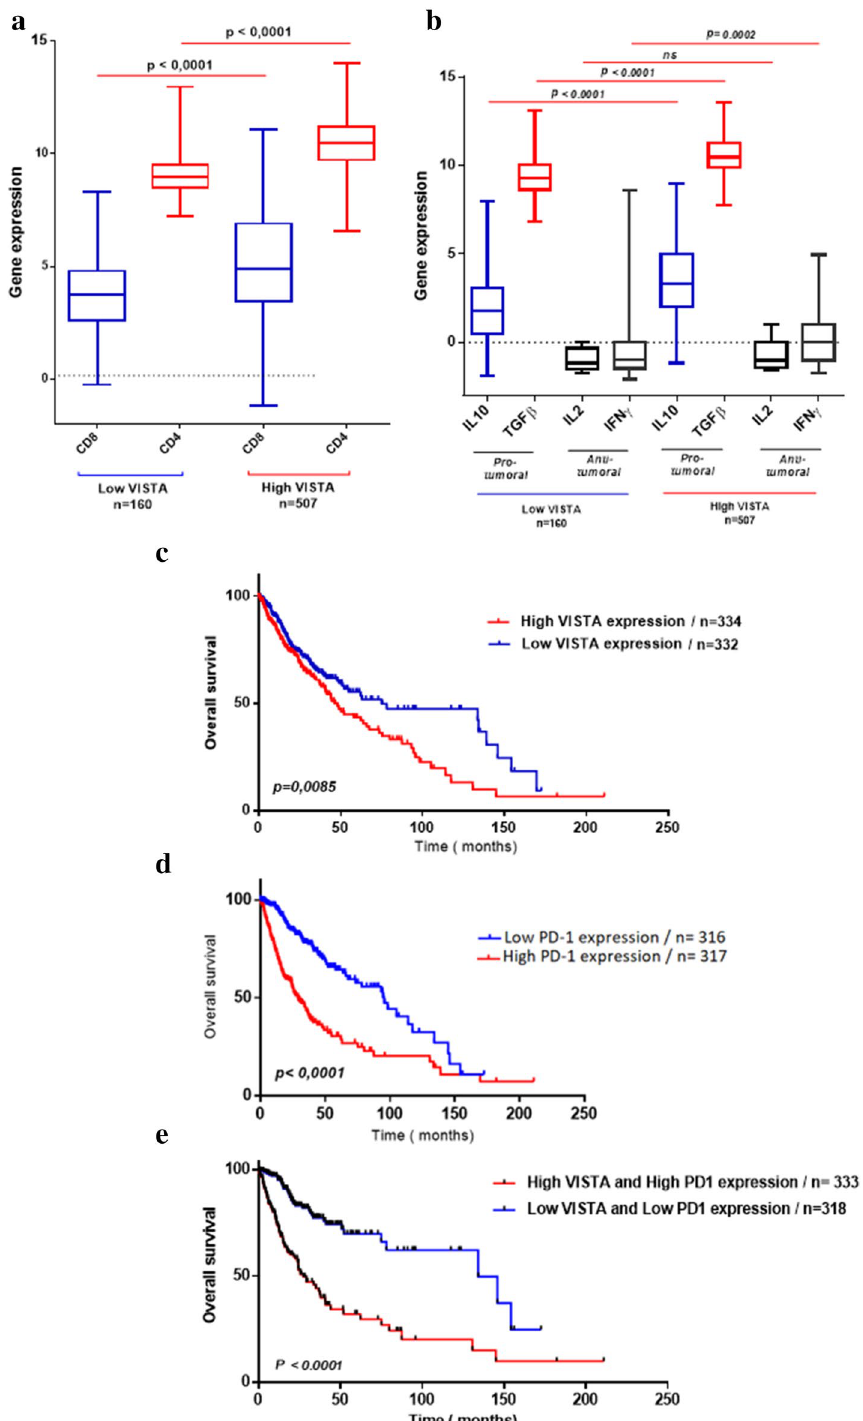
Figure 5. Increased VISTA transcripts level associated to a poor prognosis of glioma patients in the TCGA dataset. A binary clustering of patients has been performed, using the median as a cut off for patient stratification: one group with a high expression of VISTA and a second one with lower expression. ( a ) CD4 and CD8 mRNA expression were both elevated in high versus low VISTA expression. ( b ) The immunomodulatory genes ( TGF-β , IL-10 and IFNγ ) showed high expression in glioma patients with higher levels of VISTA gene expression. ( c ) High VISTA expression levels associated with a bad overall survival. ( d ) Elevated expression of both VISTA and PD-1 correlated with a weak survival. Paired t-test was used to make statistical comparison of gene expression between groups. The prognostic value of VISTA gene was investigated by Log-rank test using the Kaplan–Meier plot. p value less than 0.05 was considered as statistically significant for all statistical